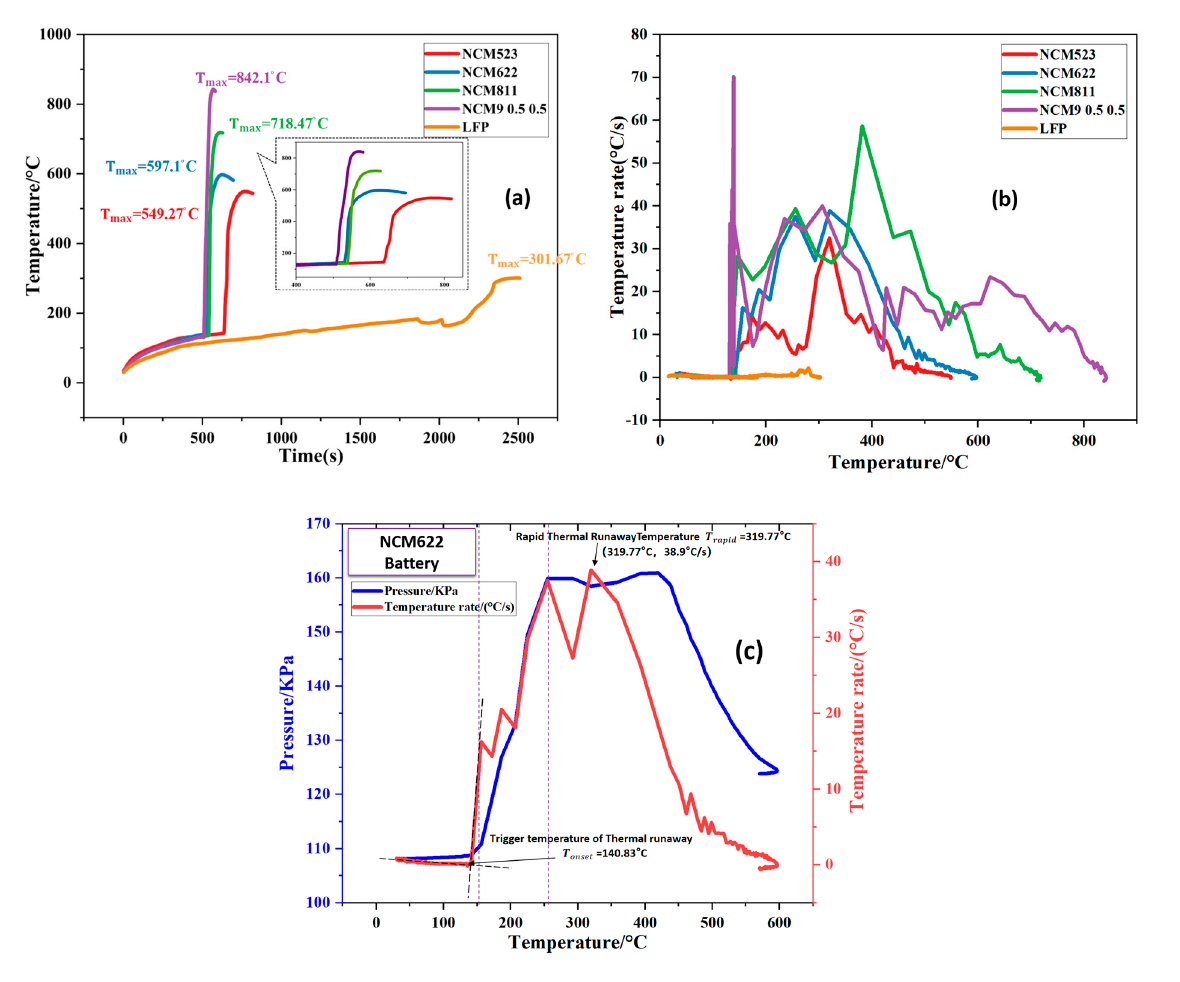
Figure 5. ( a ) Image of temperature change during TR of different battery ( b ) (temperature change rate-temperature) curves during TR of batteries. ( c ) Acquisition method of battery TR trigger temperature T o nset . Table 3. Data recorded during battery